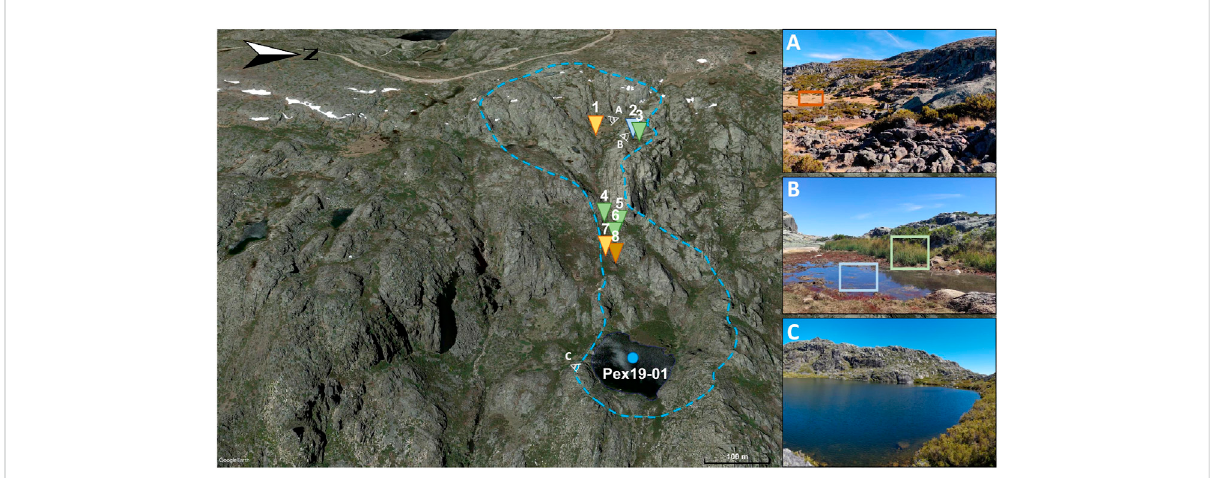
FIGURE 2 TheLakePeixãoarea.Thelight-bluedashedlinerepresentstheupslopewatershedcontourobtainedfromtheelevationmodelofGoogleEarth Pro. The enumerated triangles represent sites of sample collection: 1 — Agrostis sp.; 2 — Antinoria sp.; 3 — Juncus sp.; 4 — Cytisus sp.; 5 — Juniperus sp. and respective litter; 6 — Erica sp. and respective litter; 7 — Nardus sp. and respective litter; 8 — Soil sample. Colors represent orange – grasses; light blue – aquaticgrass;lightgreen – softrush;dark green – shrub;brown – soil.Theeye-view symbolpointto theviewseenintherespectivephotos (A,B) , and (C) . Satellite imagery from Google Earth (date: 26 May